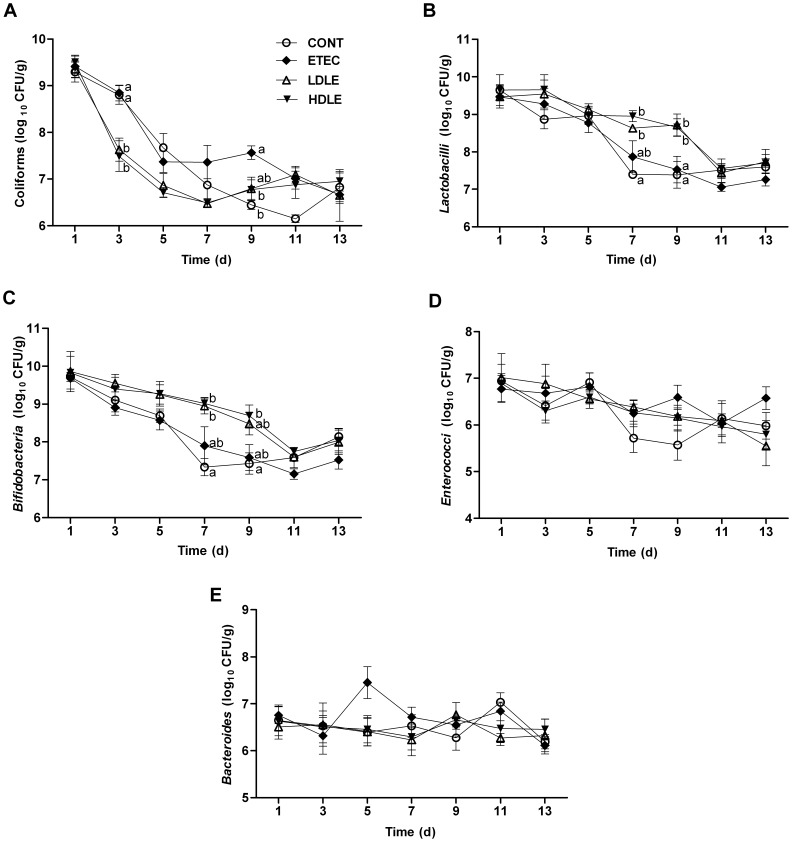

Lactobacillus rhamnosus consumption shaped the composition of faecal microbiota during F4+ETEC infection.(A) Coliforms, (B) Lactobacilli, (C) Bifidobateria, (D) Enterococci and (E) Bacteroides. Fresh faecal samples from all the piglets were collected at days 1, 3, 5, 7, 9, 11 and 13 after weaning. Results are presented as log10 CFU/g faeces, and all counts were performed in triplicate. Data are presented as means ± SEM (n = 5 per group). Within the same time, mean values with different superscript letters (a, b) are significantly different (P<0.05).